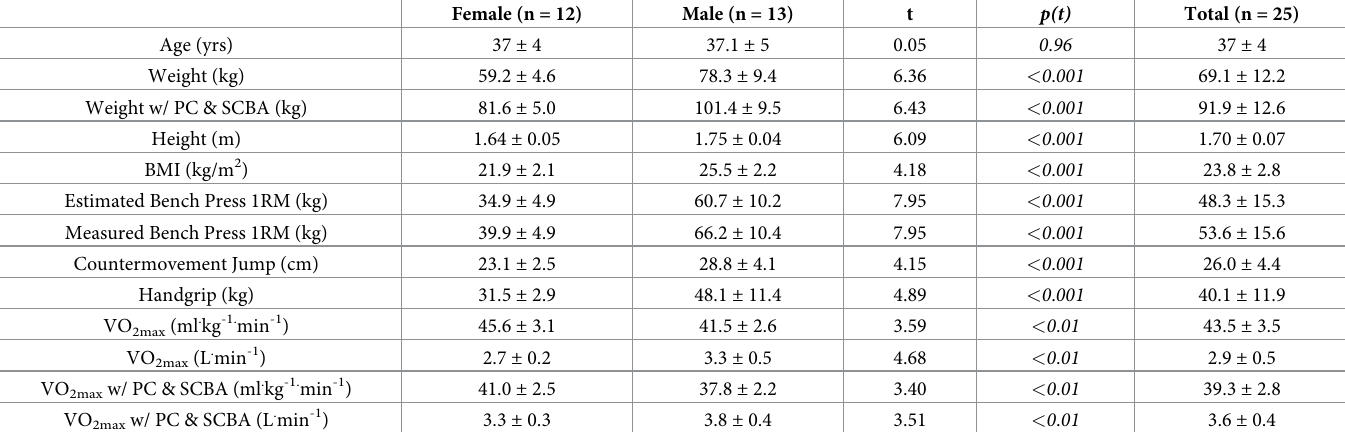
Table 1. Means, standard deviations, and statistical differences (p < 0.05) of anthropometric and fitness data across age groups.